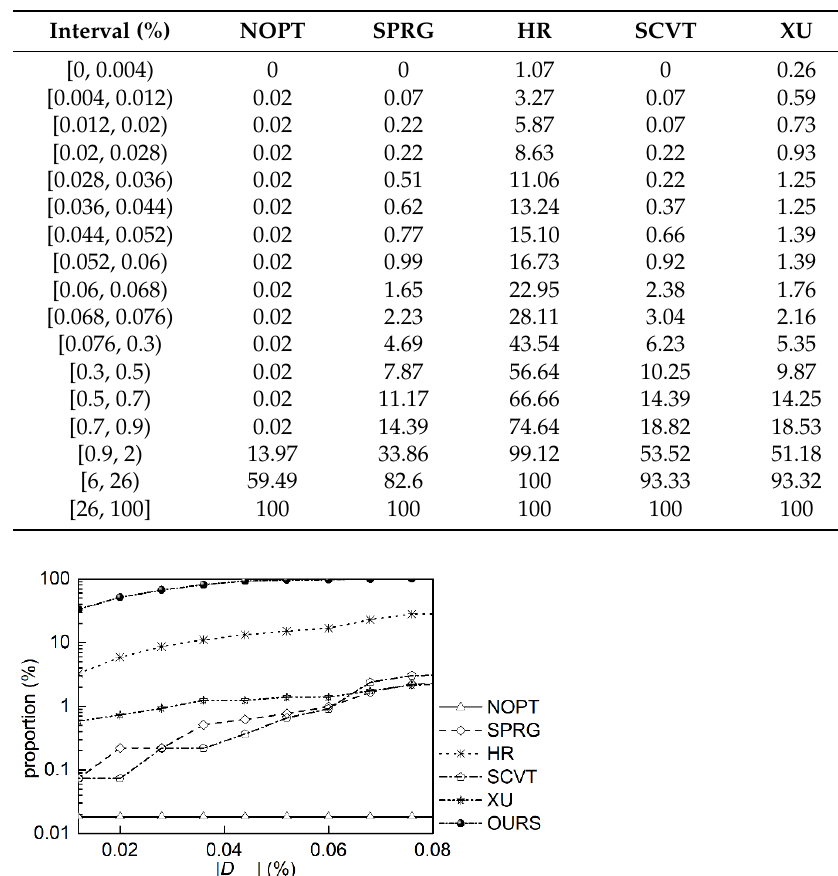
Table 5. The cumulative proportion of | D area | of different grids (%).